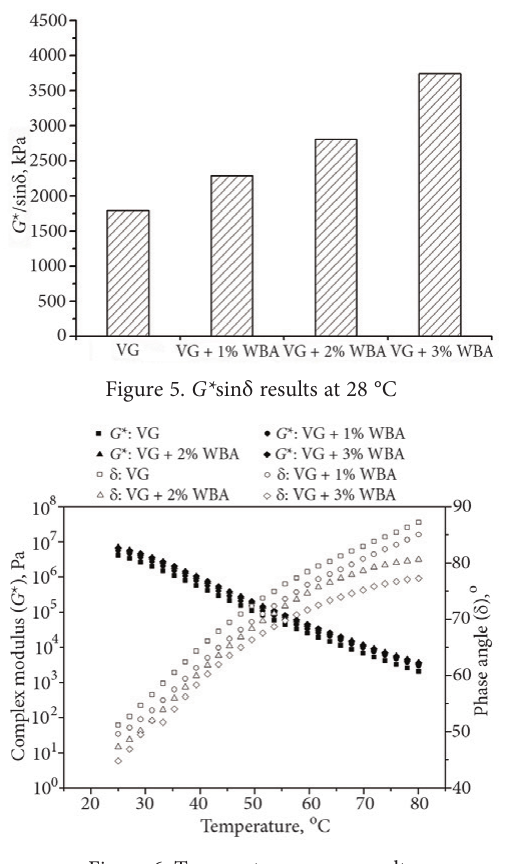
Figure 6. Temperature sweep results